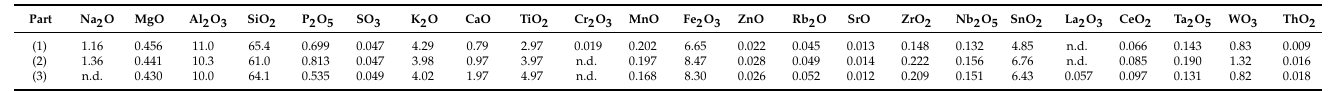
Table 3. Results from WDXRF analyses of the (alluvial) sediments collected in the Ferradal stream that runs along the eastern side of the Outeiro de Baltar hillfort. Three sub-parts (1, 2, 3) of the sediments were